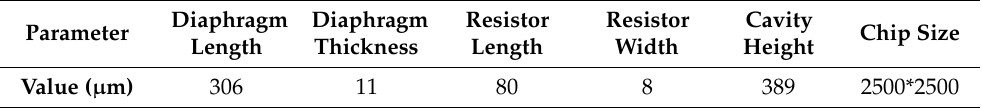
Table 2. Sizes of structural parameters of the sensor